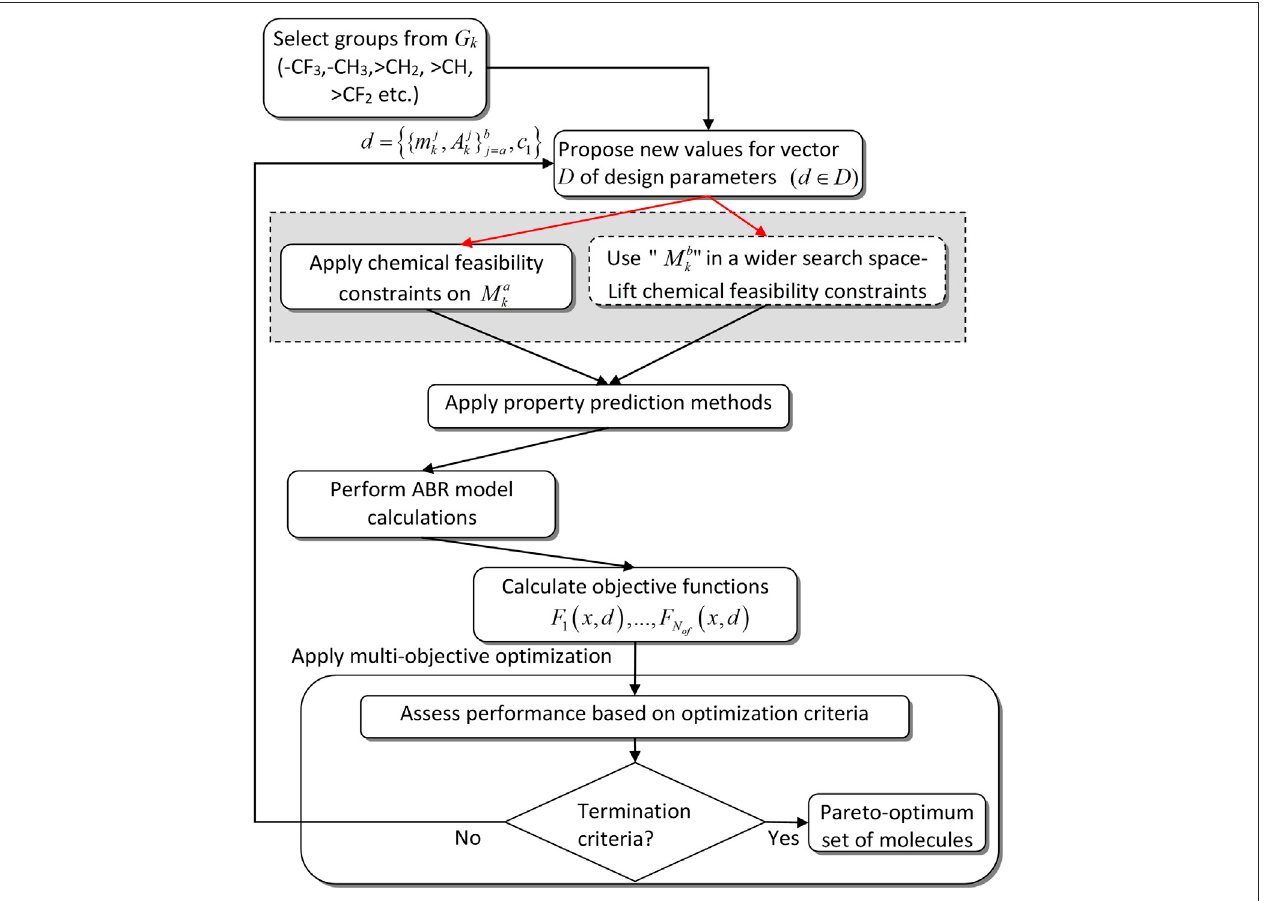
FIGURE 1 | Conceptual fl owdiagram of CAMD mixture design approach of Papadopoulos et al. Adapted with permission from Papadopoulos et al. (2013). Copyright 2013 American Chemical Society.